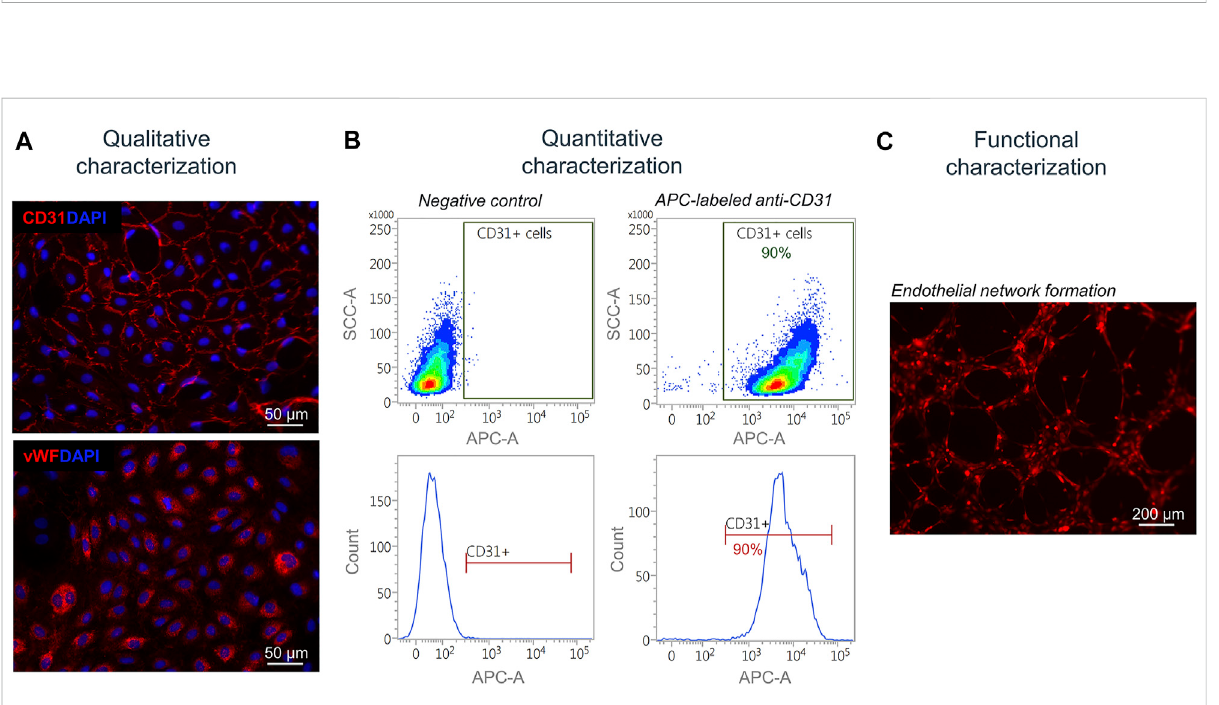
FIGURE 5 Characterization of isolated SkMVECs. (A) Immuno fl uorescence staining of isolated SkMVECs for the endothelial cell markers CD31 (pseudo- color red) and vWF (pseudo-color red). Nuclei are DAPI-stained (blue) (B) Quantitative characterization by fl ow cytometry for CD31. (C)